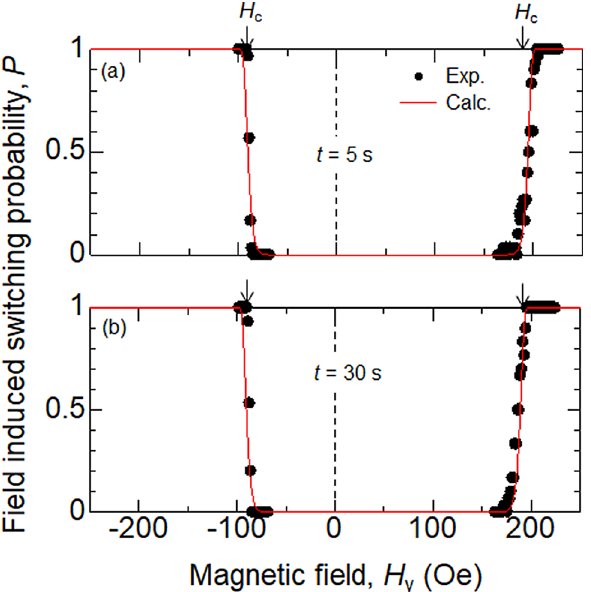
Figure 3. ( a , b ) Magnetization switching probability plotted as a function of magnetic field ( H y ). The duration of the field is 5 s ( a ) and 30 s ( b ). Symbols represent experimental data, the red solid lines show the fitting results using Eq. (1). The parameters used are: H K : 300 Oe, H s : 54 Oe, (cid:31) P = (cid:31) AP : 85 and I = 0 . The arrows represent H c obtained in Fig. 1(b).